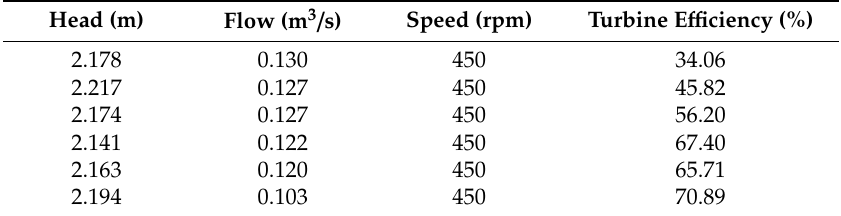
Table 5. E ffi ciency measurement at reduced head and rated